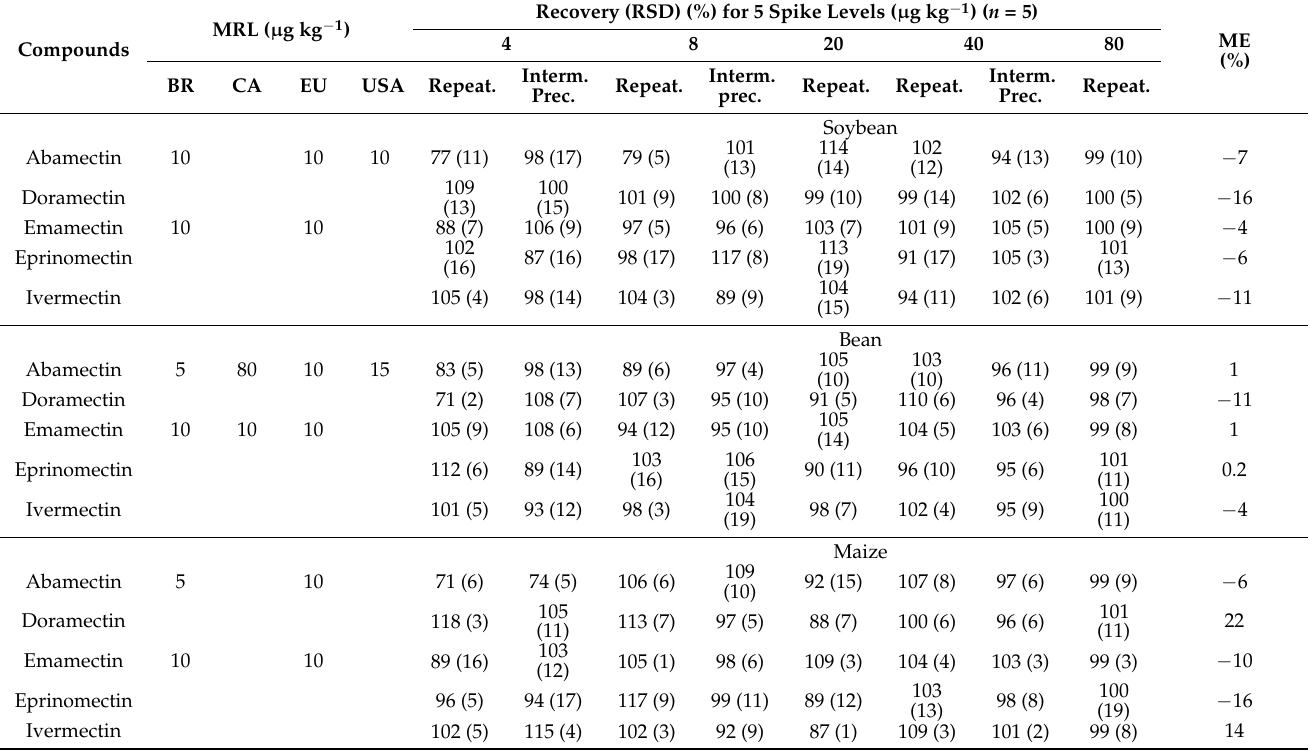
Table 2. Maximum Residues Limits, recovery (%), and relative standard deviation (RSD) (%) for repeatability and interme- diate precision assays and matrix effects (%) for each compound in the different